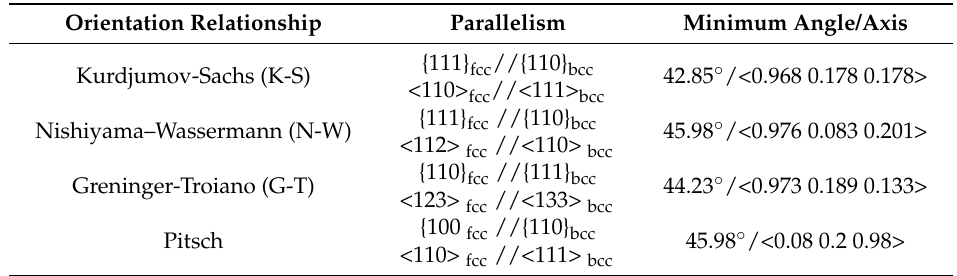
Table 1. Ideal orientation relationships between γ structure (parent austenite) and α structure (daughter bainite/martensite) [6].